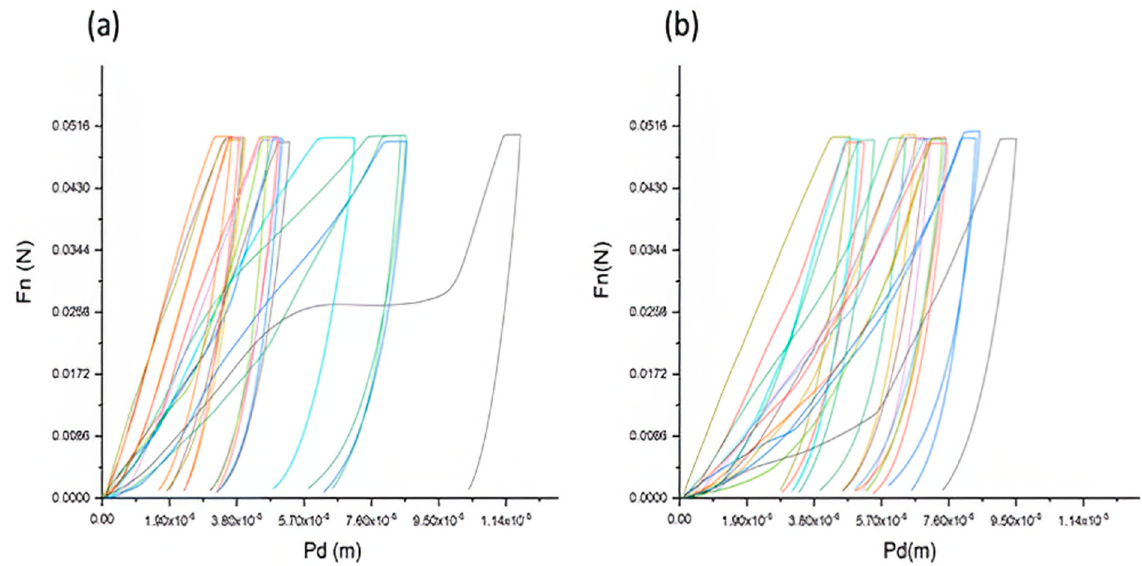
Figure 10. Fn vs. Pd curves for a CFPP-Al 1 laminate ( a ) and CFPP-Al 2 laminate ( b ); Sixteen curves are reported for each indentation point on both samples, highlighting the variability of the results obtained.